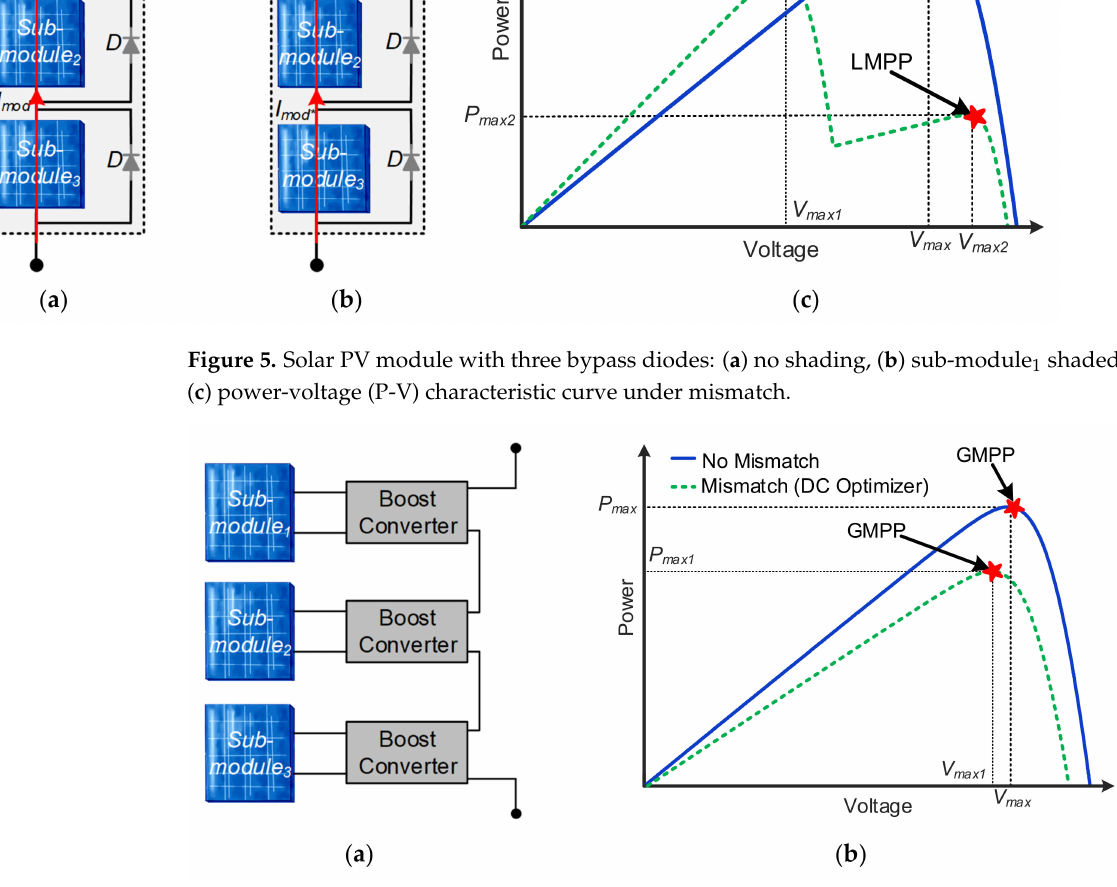
Figure 6. ( a ) DC power optimizer with boost converters and ( b ) power-voltage (P-V) characteristic curve under